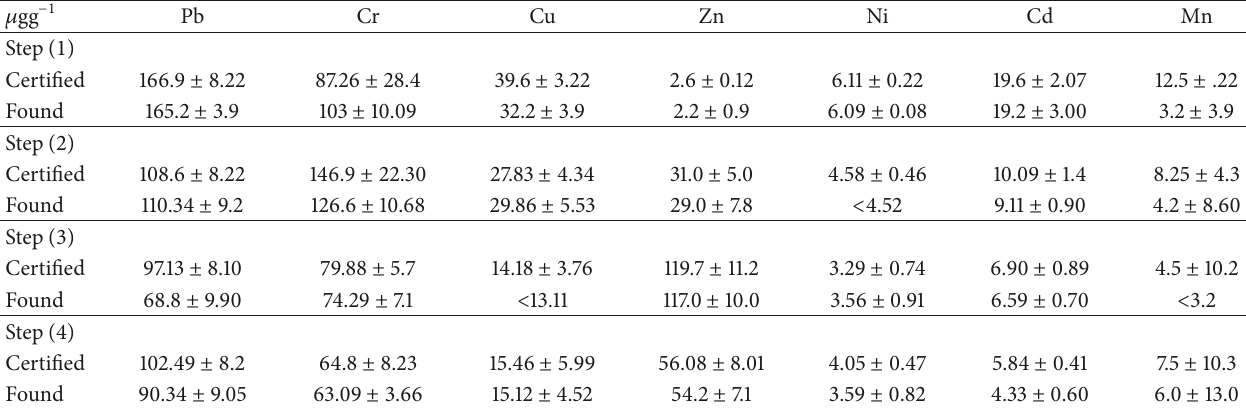
Table 4: The results of analysis of certified and found results for BCR 701 ( 𝜇 gg −1 ).